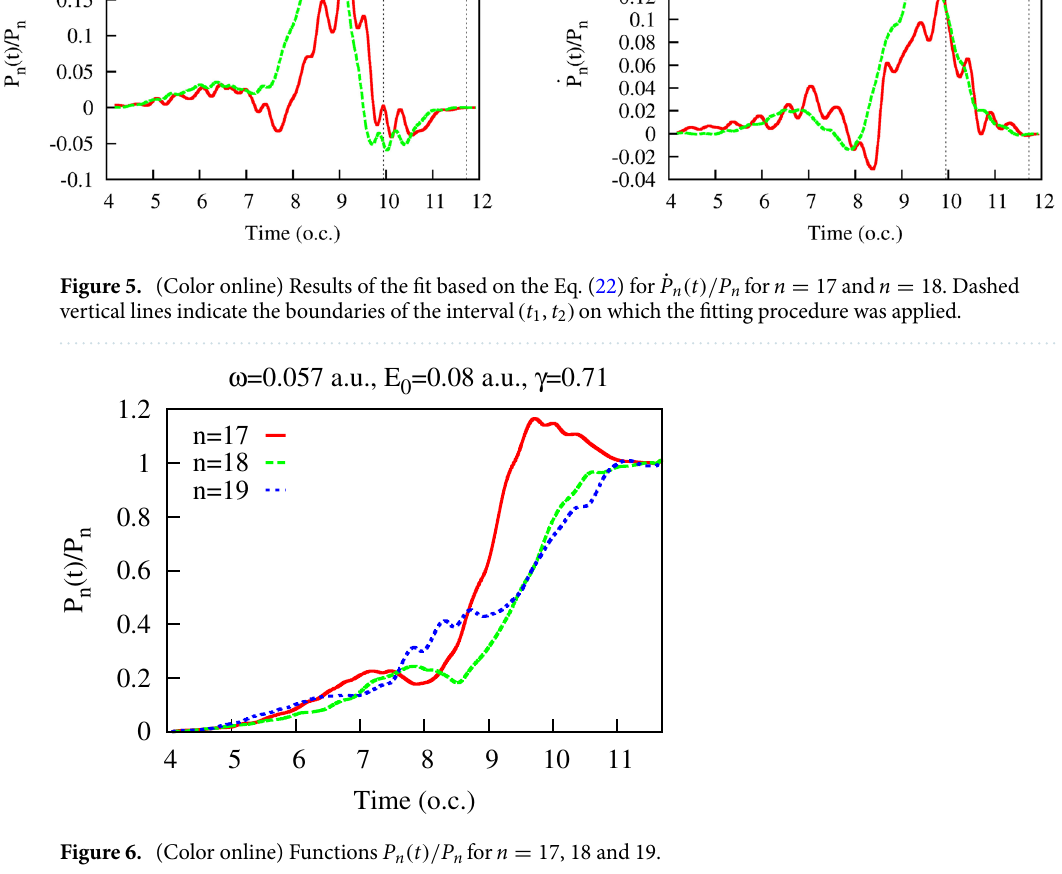
Figure 6. (Color online) Functions P n ( t )/ P n for n